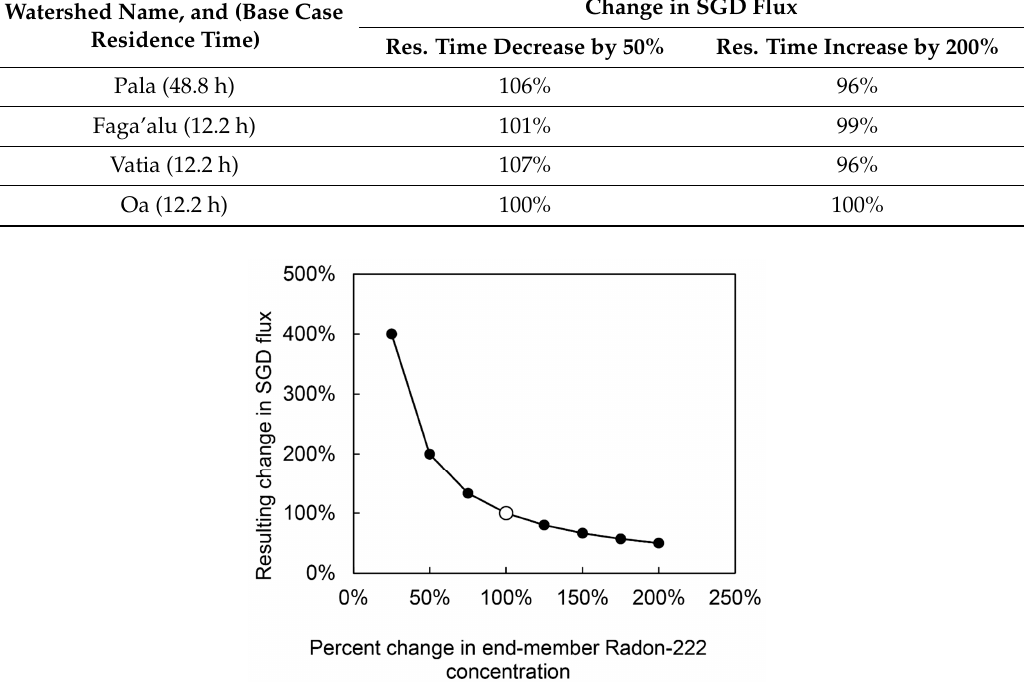
Figure A1. Sensitivity testing results for changes in end member 222 Rn concentrations used in SGD flux calculations. Base case 222 Rn end-member concentrations, originally determined by averaging 222 Rn activities for all sampled CGW sites and upgradient wells in each watershed, were multiplied by factors ranging from 0.25 to 2, and the resulting change in SGD flux for each watershed were calculated. Note that due to the linear relationship between 222 Rn end-member concentrations and SGD rates in the model, the % change in SGD for a given % change in end-member concentrations was the same for all watersheds, regardless of the absolute magnitude of the base-case end-member value.